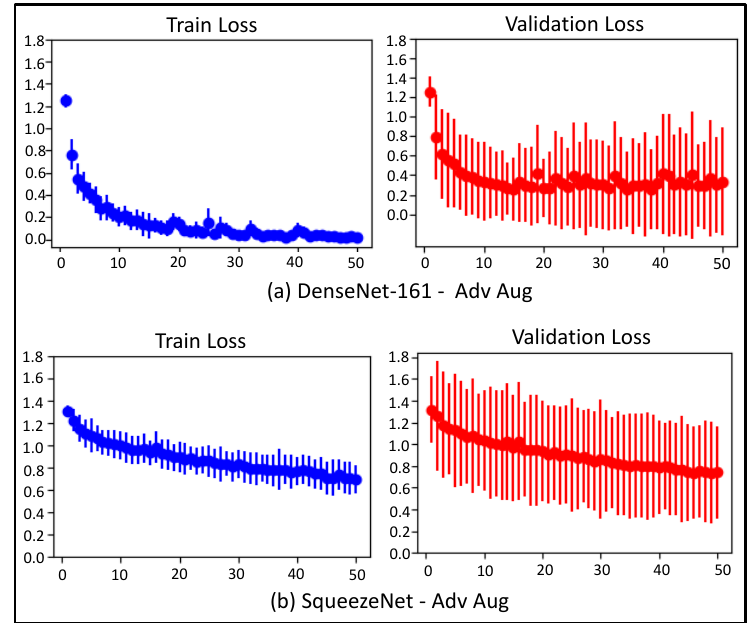
Figure 7. The train and validation loss for the fold = 0 of cross-validation. Figure ( a ) DenseNet-161 with Adv Aug configuration; ( b ) SqueezeNet with Adv Aug configuration. The reported behavior of train and validation loss trends is comparable to that of the other folds.